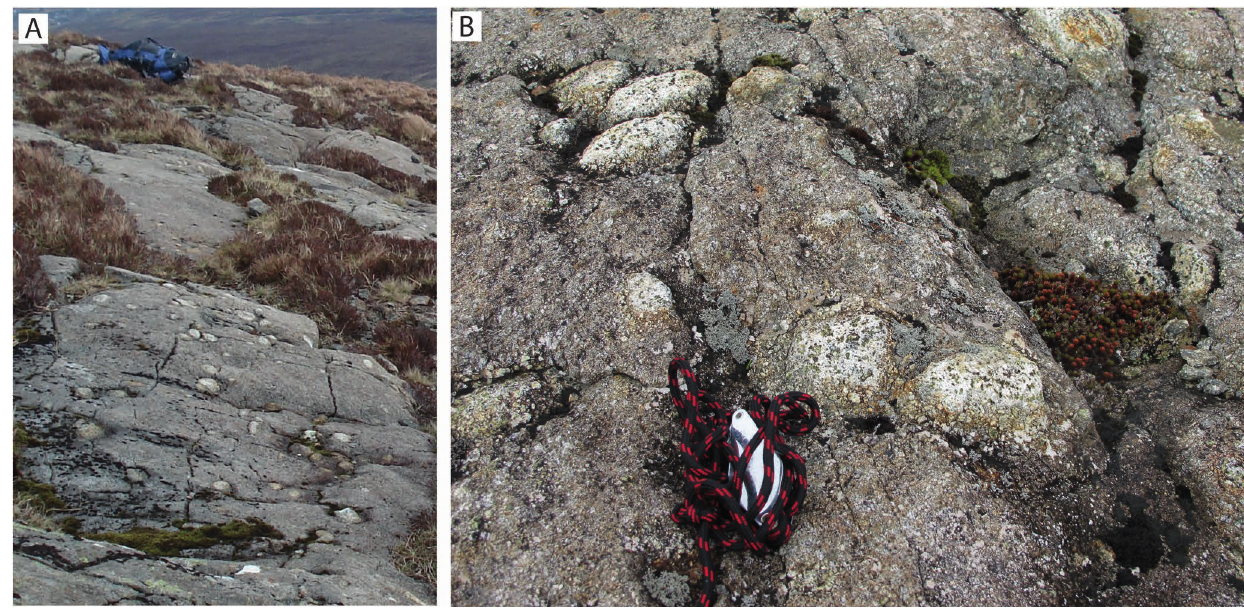
Figure 10: Field characteristics of silicic inclusions in basic intrusions. [A] Granitic inclusion bearing basic dyke from eastern summit flank of Ben Suardal [NG 63191 20477]. [B] subrounded granitic clusters within the basic dyke in